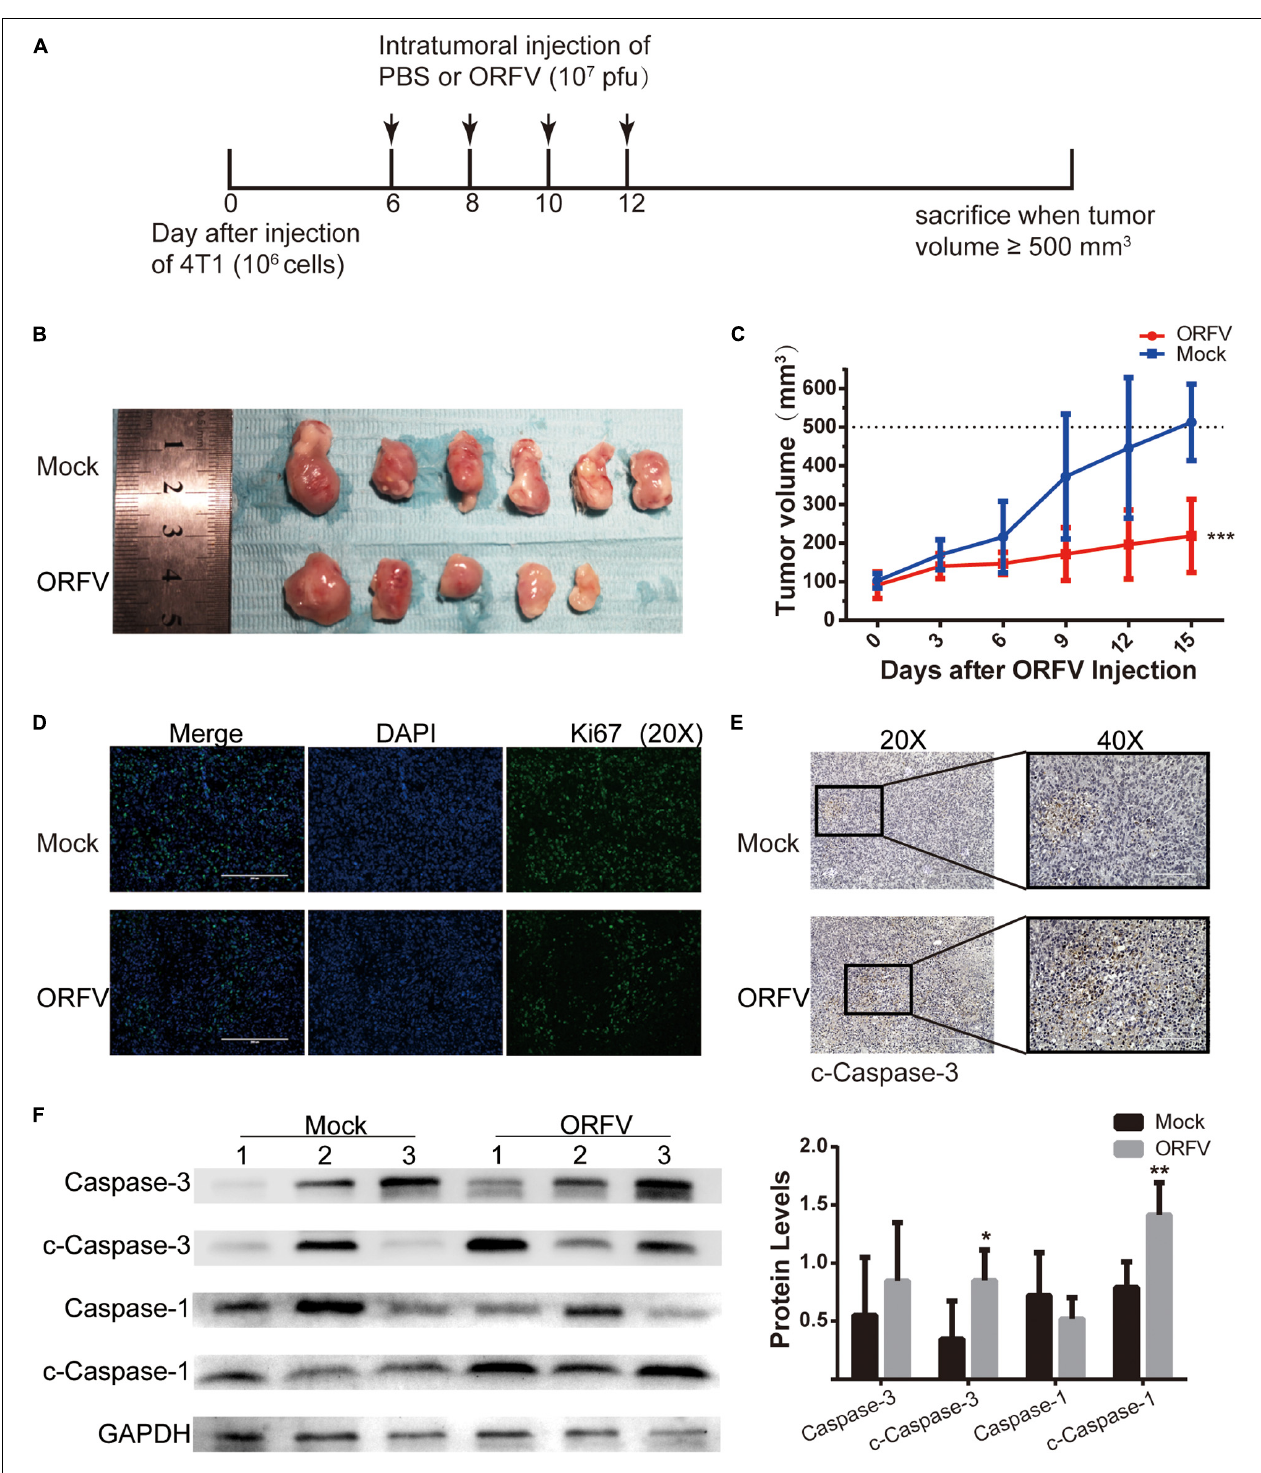
FIGURE 3 | ORFV inhibited tumor growth on 4T1 allograft tumor in BLAB/c mice. (A) ORFV treatments on tumor-bearing mice was performed in accordance with the illustrated time schedule. (B) Images of 4T1 tumor of BLAB/c mice treated with PBS or ORFV. (C) The tumor volume was measured every 3 days, and the tumor growth curve was drawn. (D) Representative immunofluorescence results of Ki67 expression in tumor tissues of BALB/c mice treated with PBS or ORFV. (E) Representative IHC results of c-Caspase-3 expression in tumor tissues of BALB/c mice treated with PBS or ORFV. (F) Western blotting analyses of c-Caspase-3 and c-Caspase-1 in tumor tissues of BALB/c mice treated with PBS or ORFV. Mock1, 2 and 3 represent three of the mice in the Mock group. ORFV1, 2 and 3 represent three of the mice in the Mock group. The results are expressed as the means ± SEM of three independent experiments. * p < 0.05; ** p < 0.01; *** p <